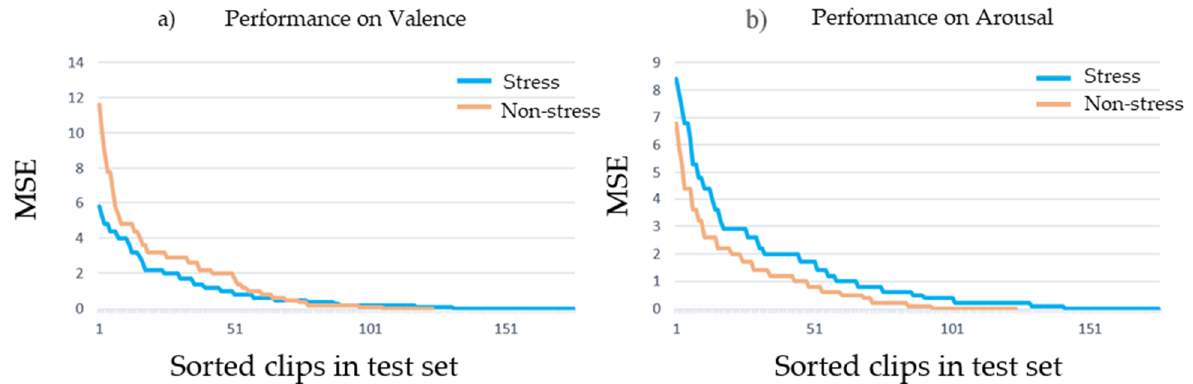
Figure 8. MSE per sample (test set, sorted) for the stress and non-stress cases.